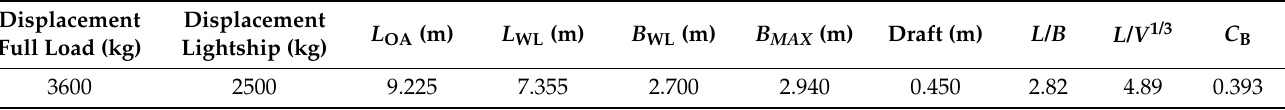
Figure 6. Detail of interceptors applied to the scale model tested in the Naples’ towing tank. Table 4. Geometrical characteristics of the KISS prototype hull.